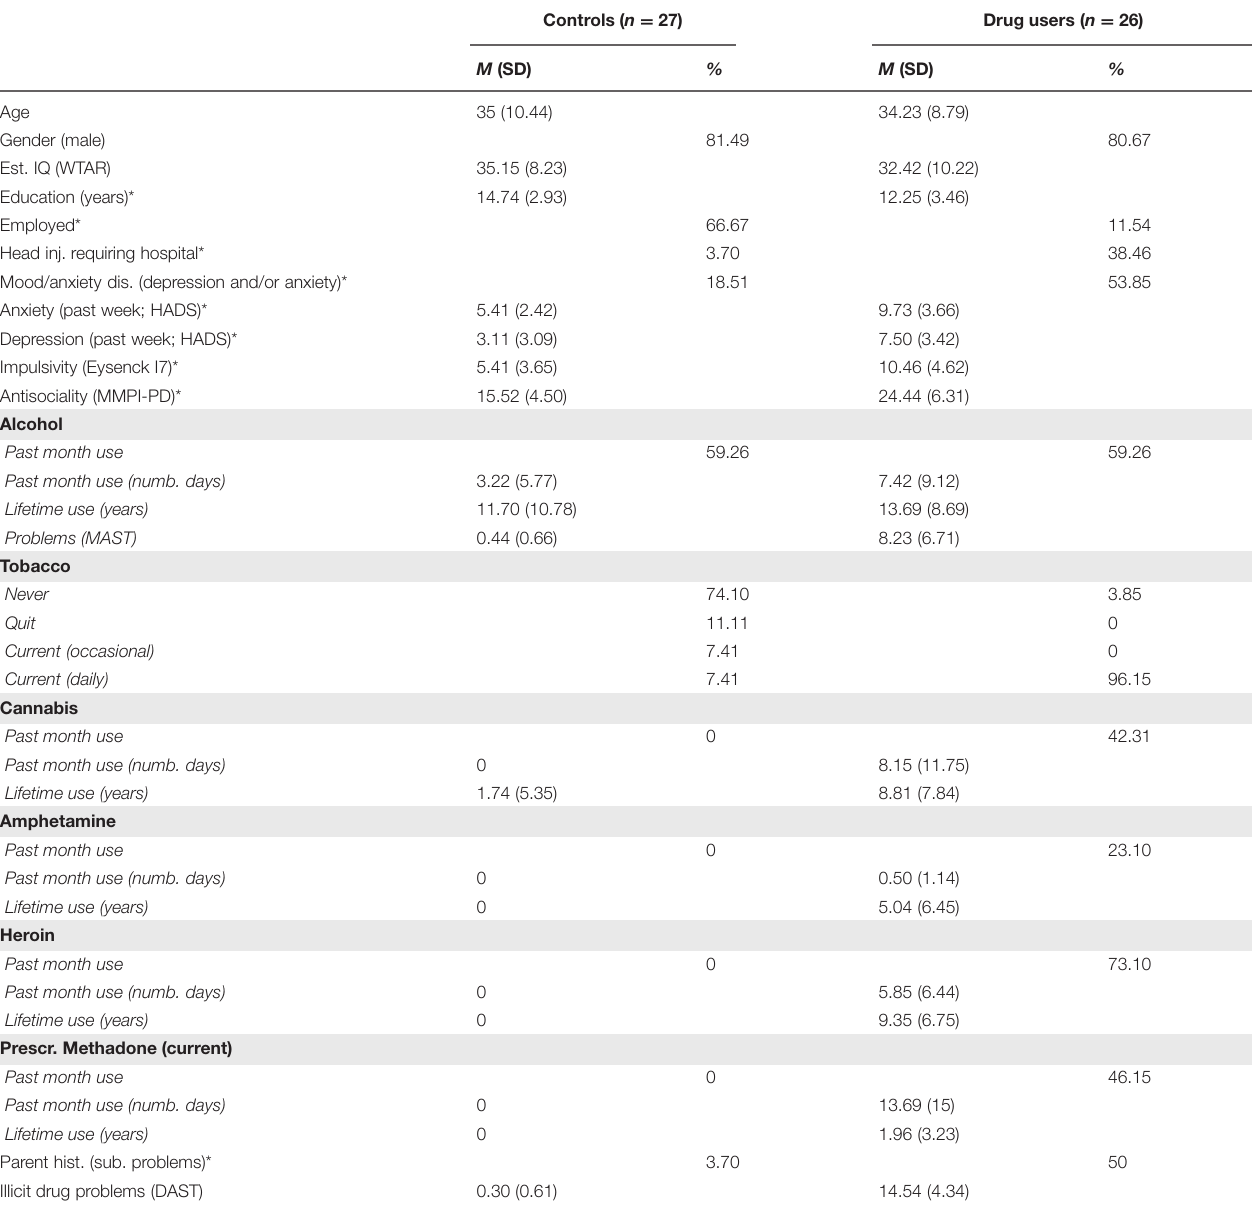
TABLE 3 | Summary of demographic, mood, personality, and substance use